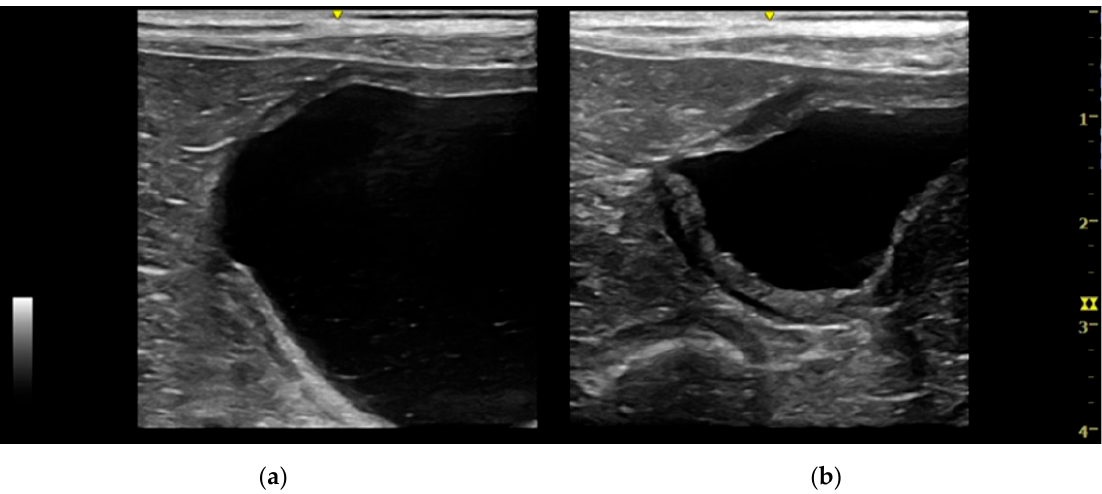
Figure 7. Two longitudinal ultrasound images of the urinary bladder of a dog with an intramural vesicourachal diverticulum. The images show two di ff erent volumes of urine into the bladder vesicourachal diverticulum. The images show two different volumes of urine into the bladder lumen. ( a) Overly distended: the diverticulum appears as a not very visible focal depression in the cranial- ventral aspect of the bladder, with thinning of the correspondent bladder wall; ( b) ddequately distended: the diverticulum appears as an evident, focal, evagination in the cranio-ventral aspect of the bladder.